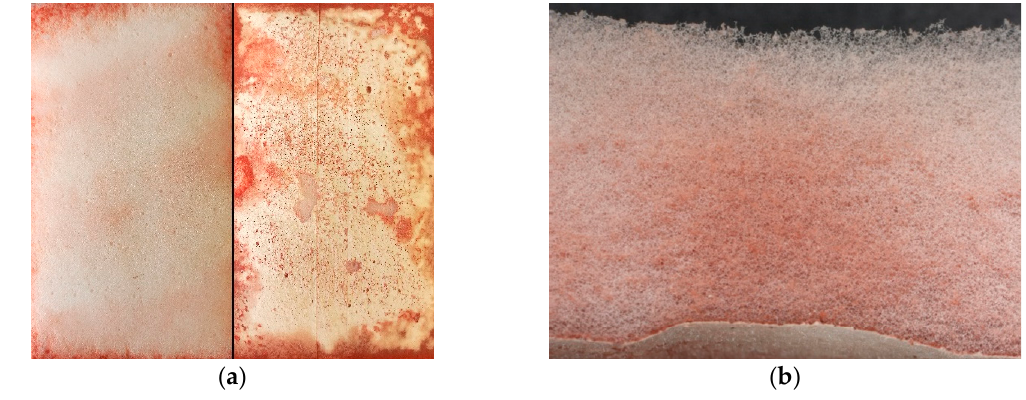
Figure 10. ( a ) topside ( left ) and bottom side ( right ) of a melamine sponge treated with CAF1 and ( b ) Sectional view of the superhydrophobic porous material.